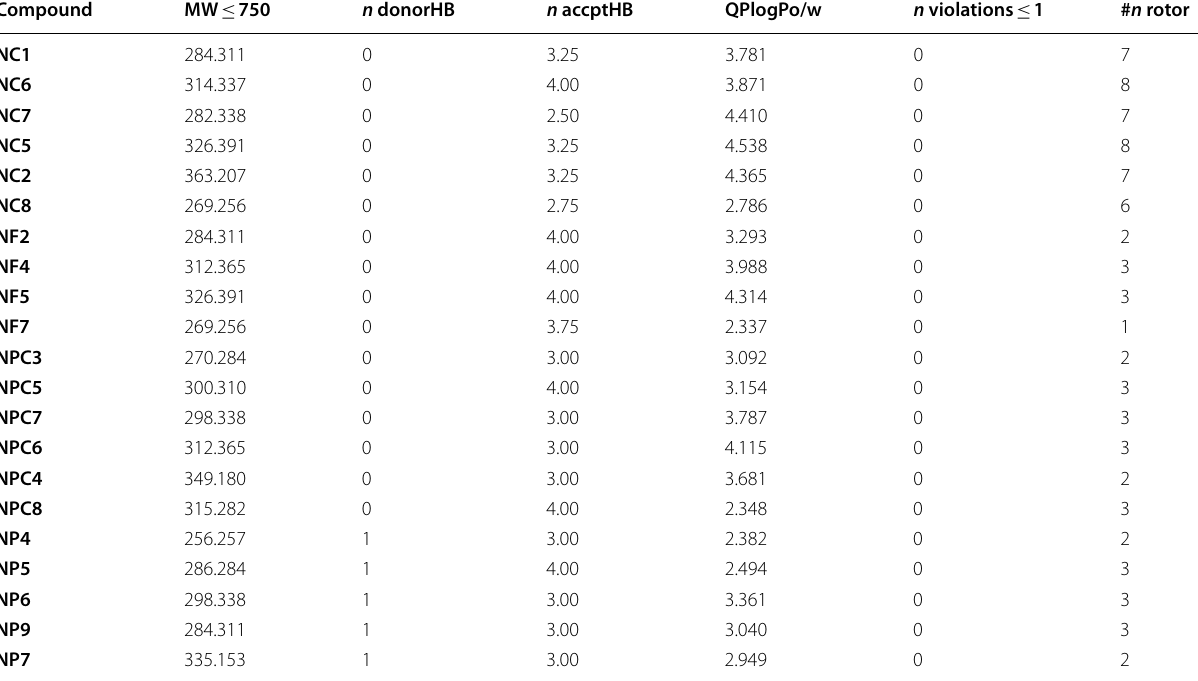
Table 2 Drug-likeness based on Lipinski parameters and the number of rotatable bonds of the synthetic compounds